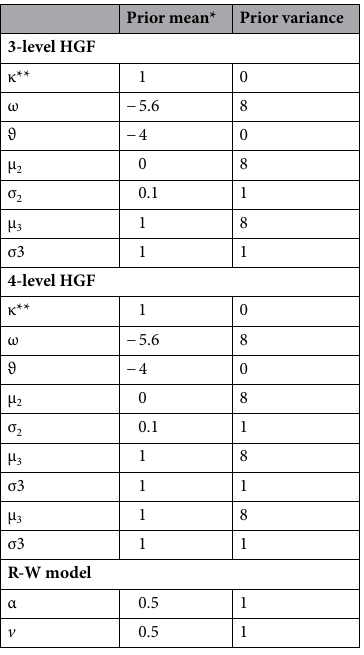
Table 1. Prior means and variances of the perceptual models. *The HGF class prior means were determined by running a Bayes-optimal simulation of the task (where the variances were set wide to account for individual